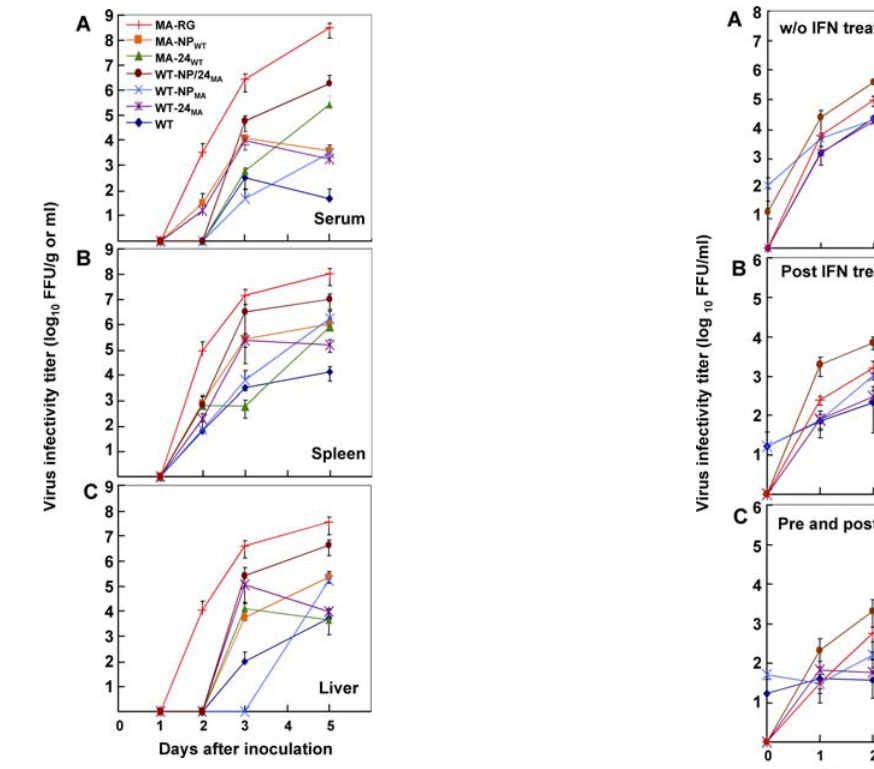
Figure 3. Growth Characteristics of Recombinant Viruses in Mice Groups of 12 mice were inoculated i.p. with 5 FFU (approximately 500 LD 50 values for MA-ZEBOV) of representative viruses. On days 1, 2, 3, and 5 postinoculation, selected organs were removed from three infected animals per group. Virus titers in serum (A), spleen (B) and liver (C) were determined in Vero E6 cells by using a focus-forming assay [36]. DOI: 10.1371/journal.ppat.0020073.g003